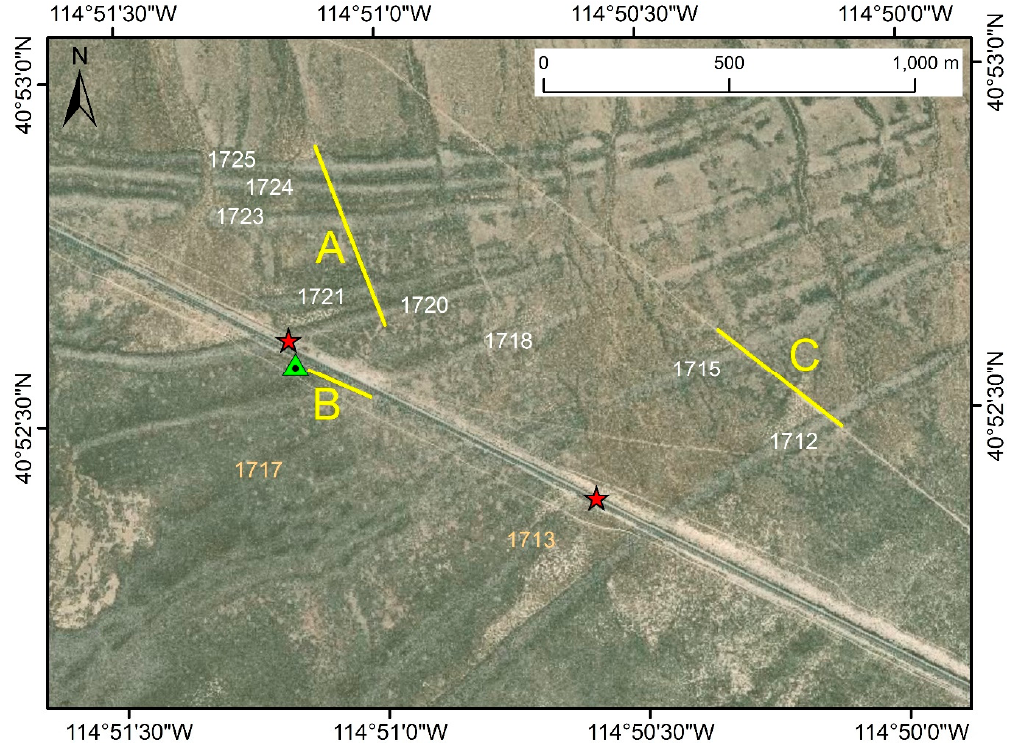
Figure 2. True color aerial image of the study area. Ten separate beach berms are obvious as linear features extending from the upper right to lower left. Color contrast reflects the presence of a different vegetation community on the drier, windswept crest of each ridge. The prominent line from upper left to lower right is the Union Pacific railroad. White labels mark beach ridges with the estimated elevation of the lake that constructed them (in meters above sea level). The two ridges labeled in orange (1717 and 1713 m) were not surveyed with ground penetrating radar (GPR). The three yellow lines denote the transects (A, B, and C) along which the GPR data were collected. The two red stars mark locations where the laser total station was installed for measuring topographic profiles along the GPR transects. The green triangle marks the second class 0 vertical survey point (LQ0282) to which the topographic surveys were referenced.